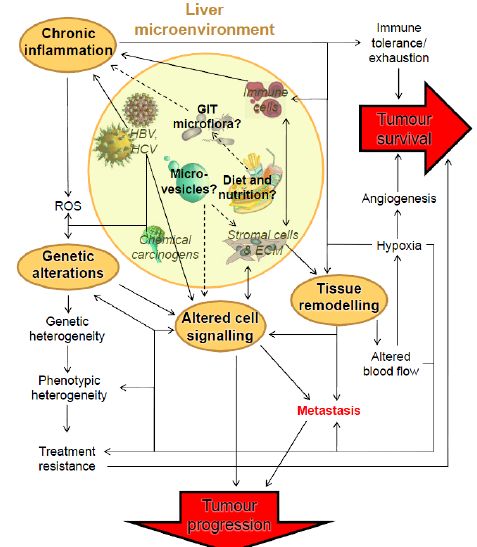
Figure 1. A simplified network of liver microenvironmental factors and their roles in HCC tumour progression and maintenance. Established causal interactions between microenvironmental factors (italicised within the dashed circle) and HCC tumour progression and maintenance are represented by solid arrows, while dashed arrows are interactions that have not yet been conclusively shown. Some known interactions are not shown for clarity. In this review, we describe the direct effects of the liver microenvironment on this network (bold): chronic inflammation; tissue remodeling; genetic alterations; and altered cellular expression. ROS = Reactive Oxygen Species; HBV = Hepatitis B Virus; HCV = Hepatitis C virus; GIT = Gastrointestinal Tract; ECM = Extracellular